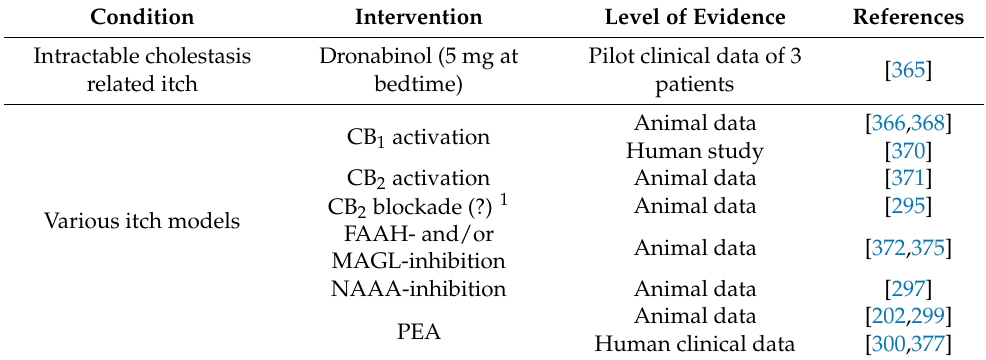
Table 7. Overview of the putative pruritus-relevant therapeutic potential of cutaneous cannabinoid